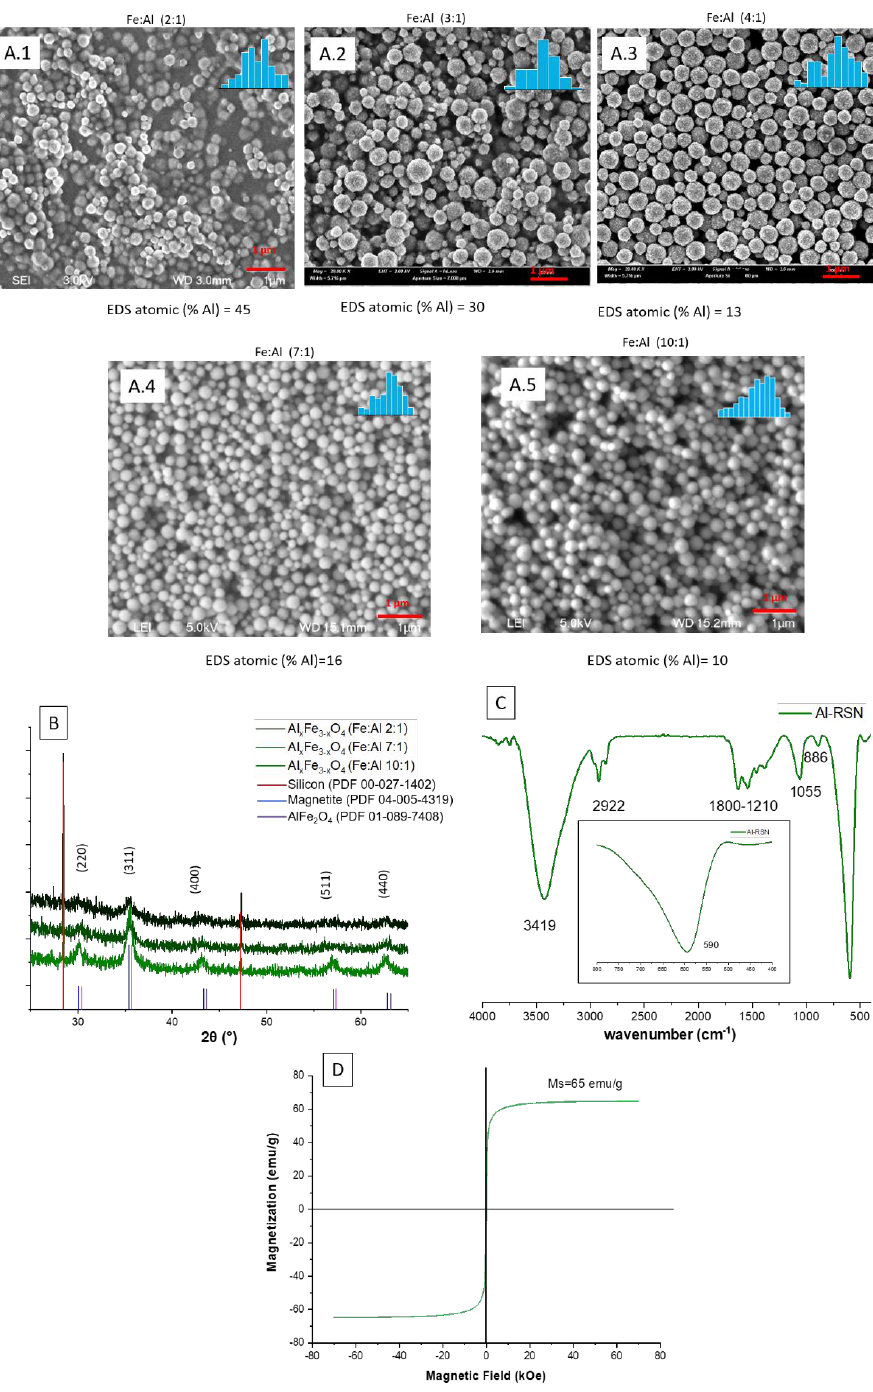
Figure 5. ( A.1 – A.5 ) SEM images of Al-RSNs (inner image: size distribution); ( B ) XRD pattern as a function of the Fe:Al ratio; ( C ) FTIR spectra (inner image: zoom of Fe–O band characteristic of a slightly oxidized magnetite phase); ( D ) magnetization curve of Al-RSNs at 300 K. To ensure a high adsorption of phosphate at the surface of iron oxide nanostructures, it is important to favor electrostatic interactions between phosphate and the iron oxide